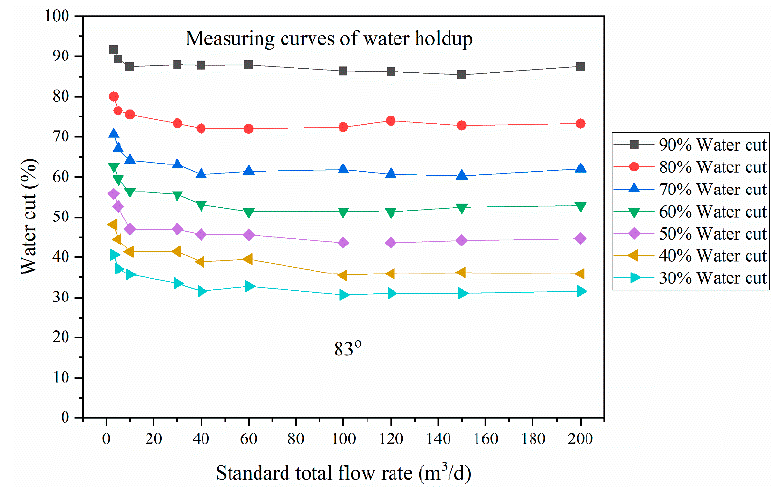
Figure 6. Water holdup measurement chart (inclination angle 83°).